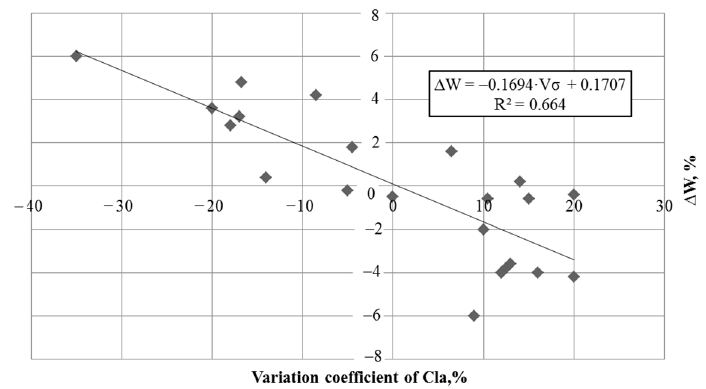
Figure 3. Change of water cut vs coefficient of light absorbance variation [100].